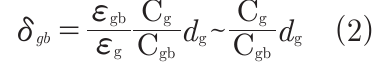
rather than Gd. This behavior affects both bulk and grain boundary electrical properties. In the bulk, the conductivity is higher probably due to the augment of oxygen vacancies with the formation of solid solution among Gd